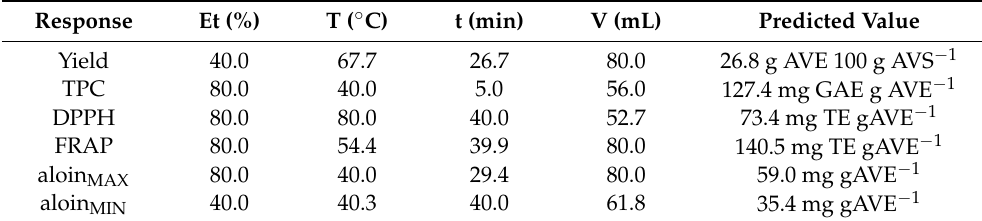
Table 4. Single response optimized extraction conditions and predicted